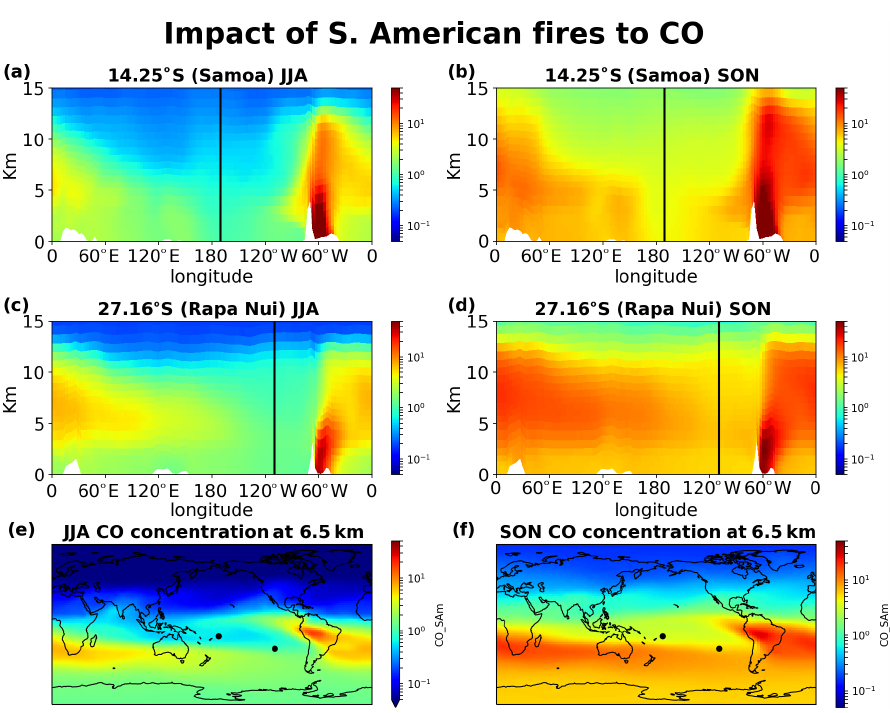
Figure 12. Impact of South American fires on CO concentrations. (a) JJA and (b) SON 20-year mean impact at the cross section of Samoa, (c) JJA and (d) SON at the cross section of Rapa Nui, and (e) JJA and (f) SON horizontal distribution of the contribution at 6.5km altitude.